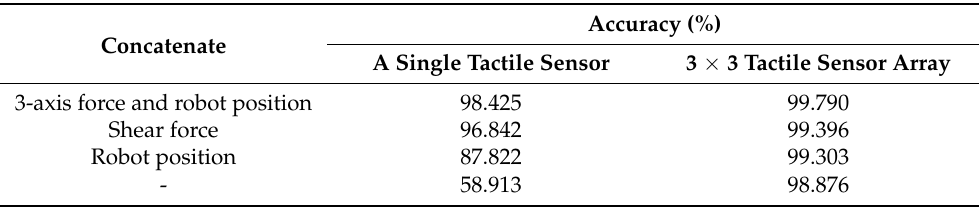
Table 3. Accuracy results of texture classification of tactile sensor concatenated with shear force and robot